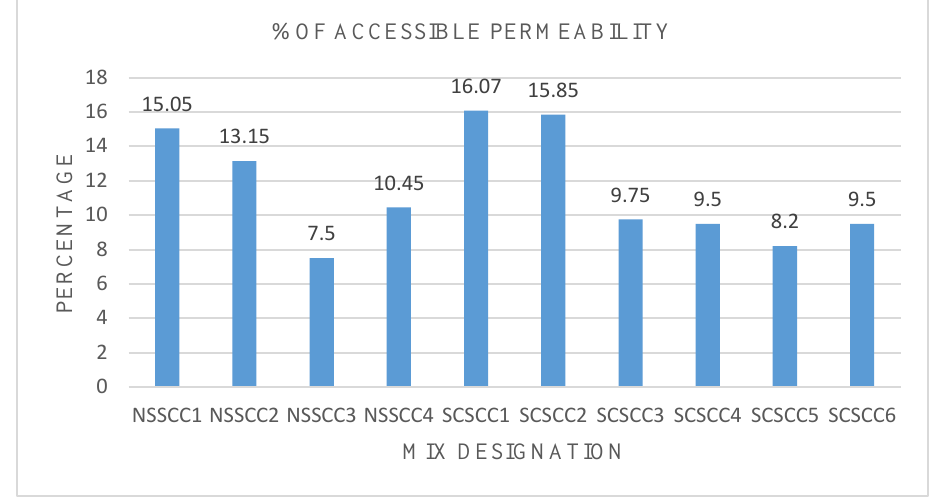
Fig. 32. Percentage of water accessible